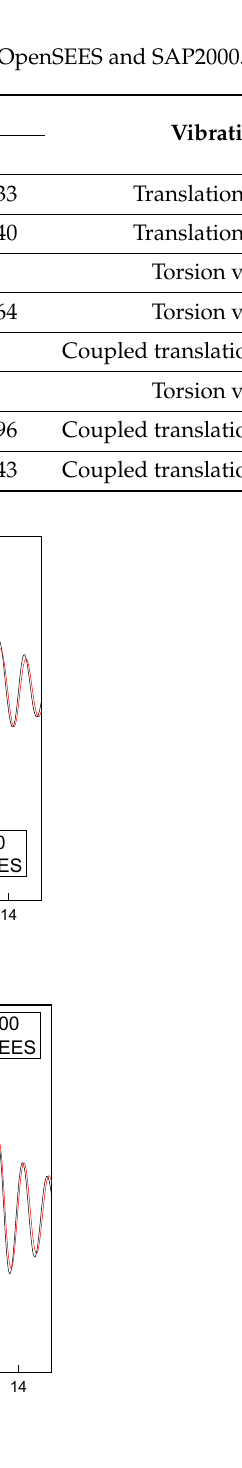
Figure 4. Response comparisons of the structure model in OpenSEES and SAP2000. ( a ) Acceleration, ( b ) Displacement. Table 1. Comparisons of modal analysis results from OpenSEES and SAP2000.